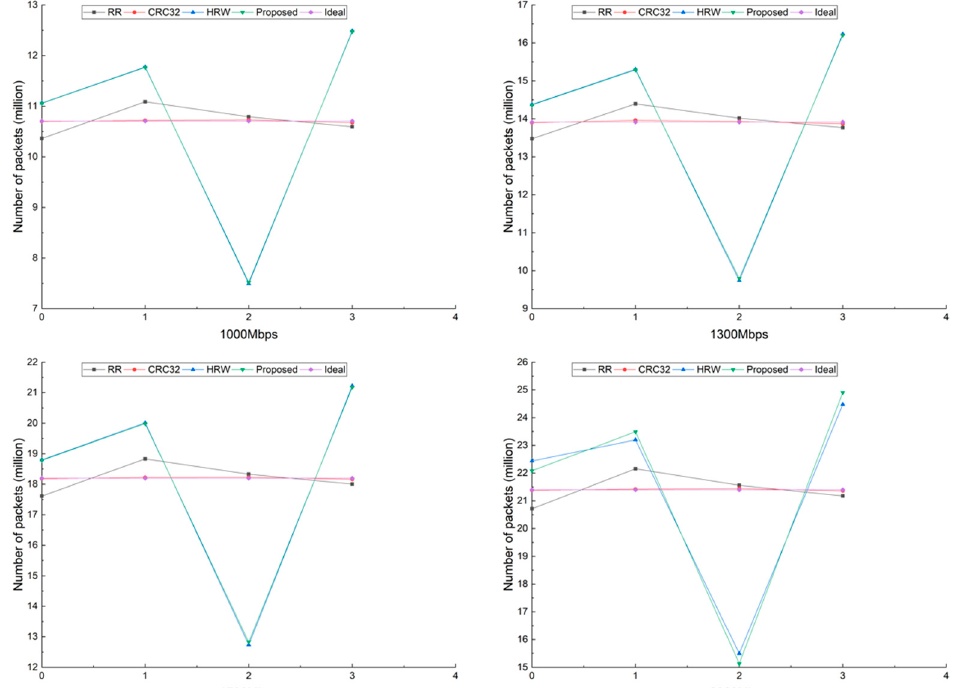
Figure 2. Number of packets on each processing core under different throughputs.